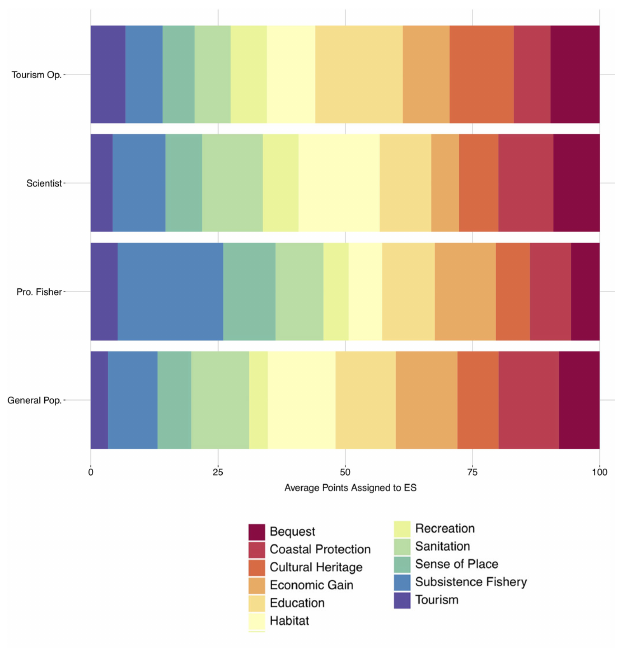
Fig. 3 . Average scores of ecosystem services by profession group.